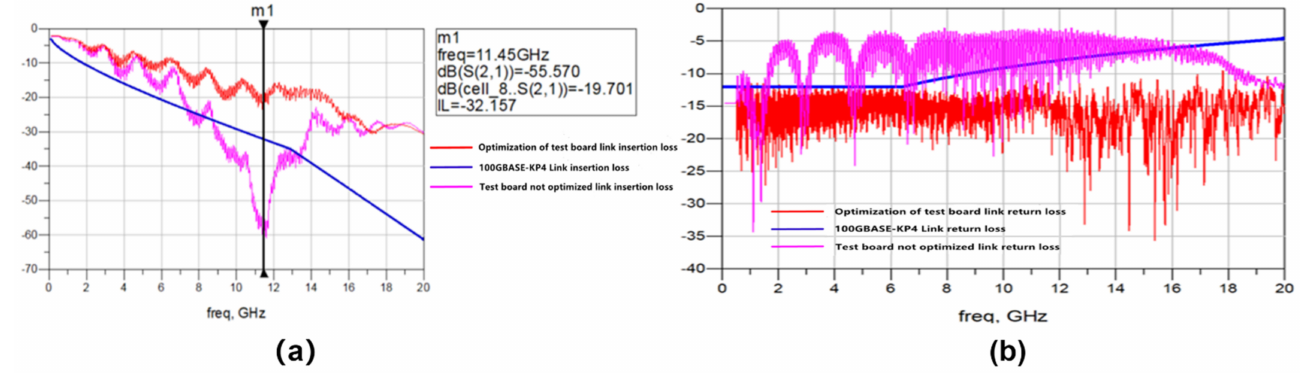
Figure 15. ( a ) Insertion loss diagram of actual test; ( b ) return loss diagram of actual